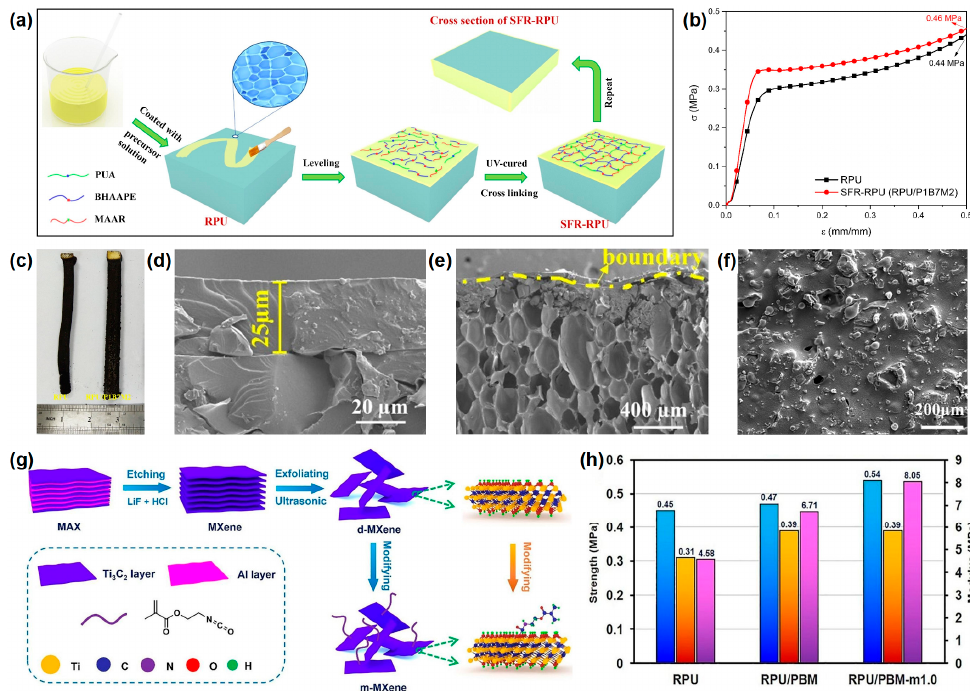
Figure 10. ( a ) Illustration of the SFR-RPU foam fabrication, ( b ) compression strength curves of pure RPU and RPU/P1B7M2, ( c ) photographs of pure RPU and RPU/P1B7M2 after UL-94 testing, ( d ) SEM of the interface where the RPU foam contacts with the coating, ( e ) cross-section and ( f ) surface of RPU/P1B7M2 in UL-94 test [57], ( g ) fabrication route of m-MXene nanosheets, ( h ) mechanical bar graphs of RPU, RPU/PBM, and RPU/PBM-m1.0 [58].